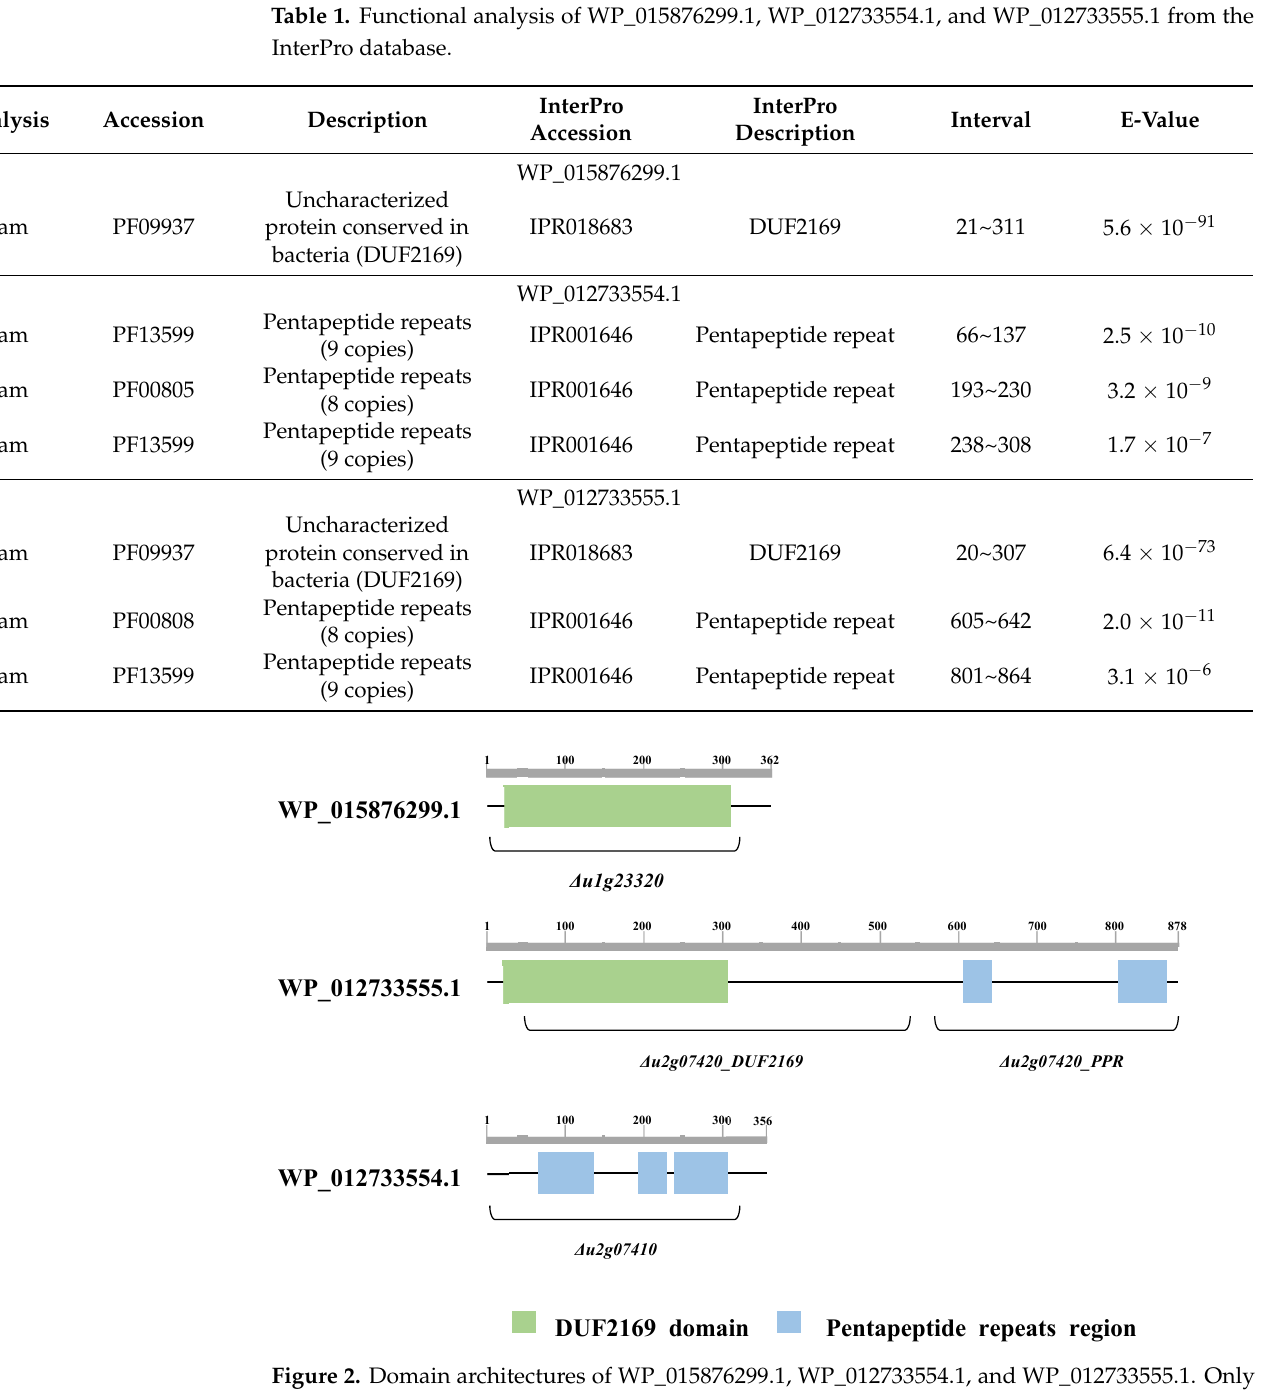
Figure 2. Domain architectures of WP_015876299.1, WP_012733554.1, and WP_012733555.1. Only proteins with distinct domain organizations are shown. The DUF2169 domain-containing protein (WP_015876299.1) encoded by bglu_1g23320 has the DUF2169 domain as a single-domain protein. The DUF2169 domain-containing protein (WP_012733555.1) encoded by bglu_2g07420 has multiple domains with pentapeptide repeats region at the C-terminus. The pentapeptide repeats protein (WP_012733554.1) encoded by bglu_2g07410 only has the pentapeptide repeats region. The deletion sites of the mutant strains used in this study are shown with ∆ u1g23320 , ∆ u2g07420DUF2169 , ∆ u2g07420PPR , and ∆ u2g07410 .